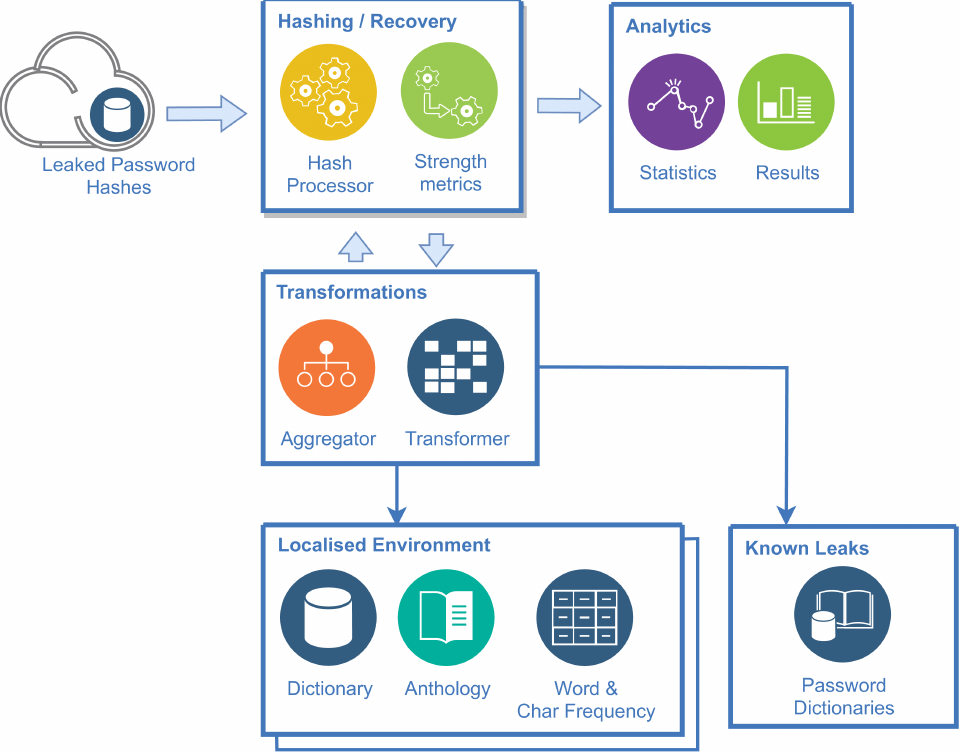
Figure 1. The flow of password recovery and